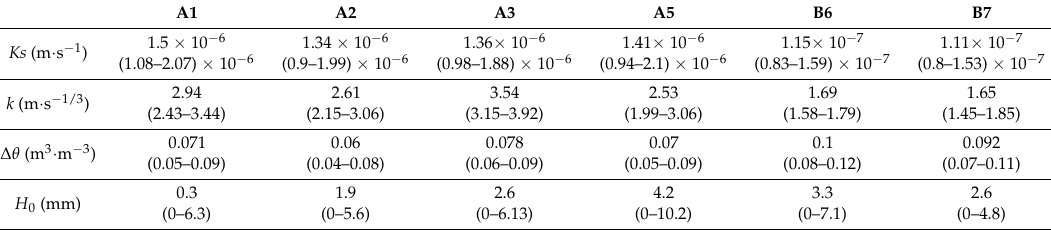
Table 4. Irrigation parameters estimated for the different irrigations. Fitted values +/ − one square root of the variance are given in